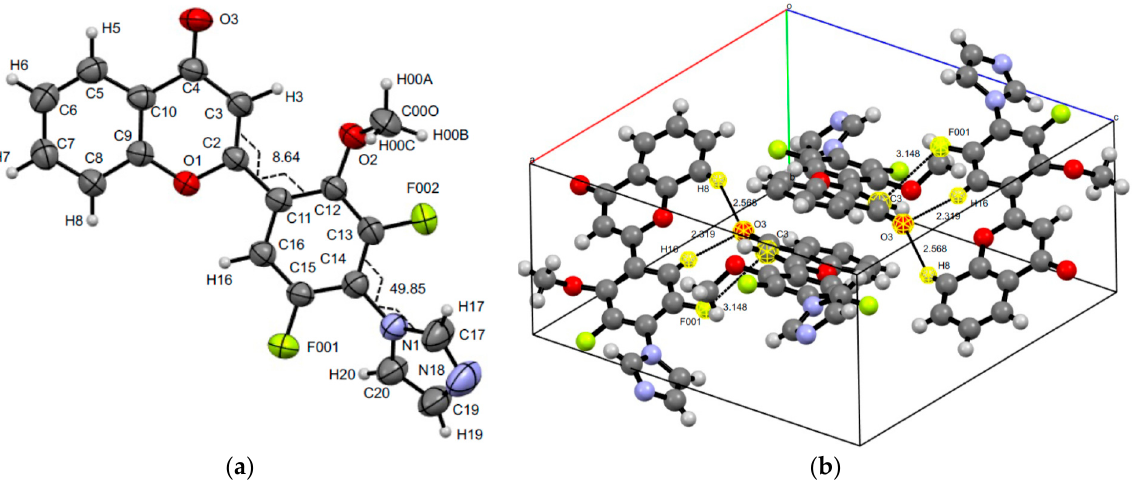
Figure 6. Molecular structure and selected torsions ( a ) and unit cell ( b ) of compound 23 with atoms represented as thermal ellipsoids of thermal vibrations with a 50% probability.